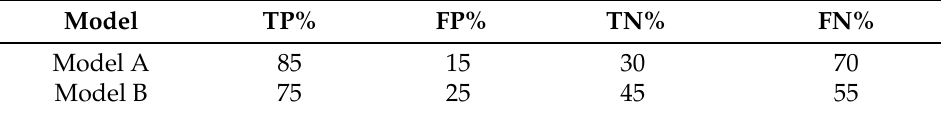
Table 4. The TP, FP, TN and FN measures for the two hypothetical